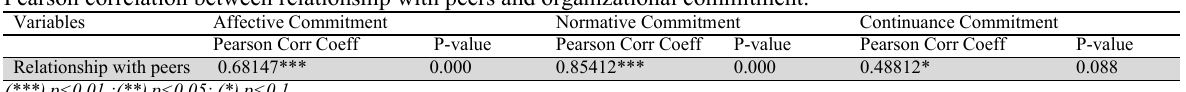
Pearson correlation between relationship with peers and organizational commitment. Variables Affective